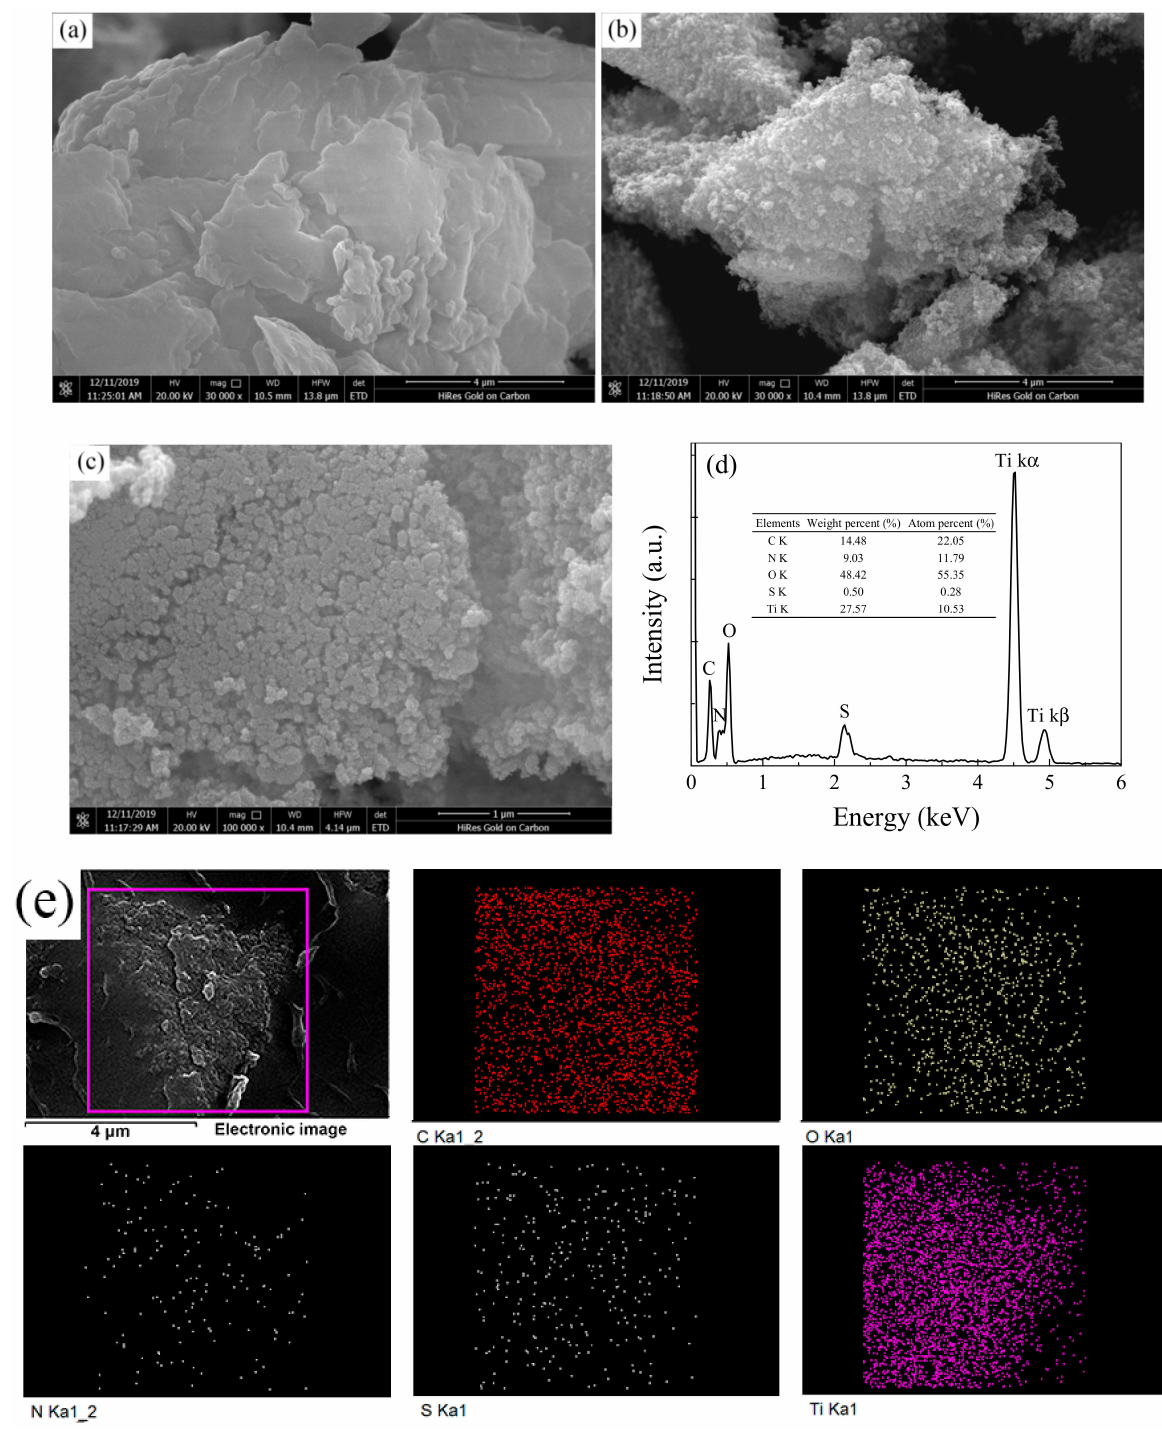
Figure 1. FESEM images of the surface morphologies of wool pallets ( a ) 30,000 × before and ( b ) 30,000 × and ( c ) 100,000 × after treatment with TBT in a hydrothermal process; ( d ) EDX spectrum and ( e ) element mapping of the WT powders. The TEM images of the cross-section of the WT powders and the corresponding selected area electron diffraction (SAED) patterns were shown in Figure 2b,f. It was